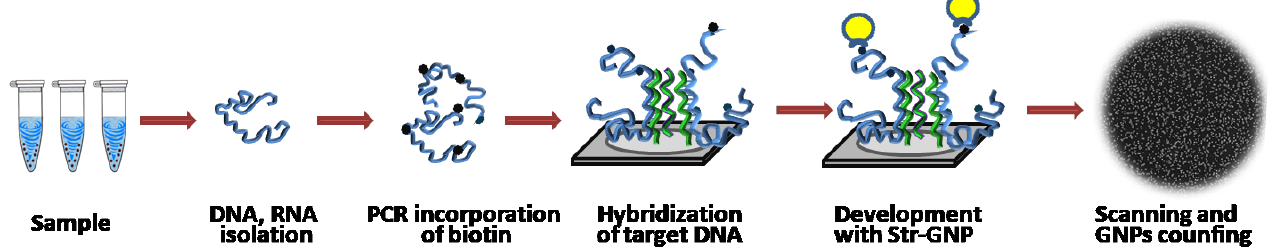
Figure 1. Scheme of successive stages of DNA hybridization analysis on microchips with digital detection of gold nanoparticles.